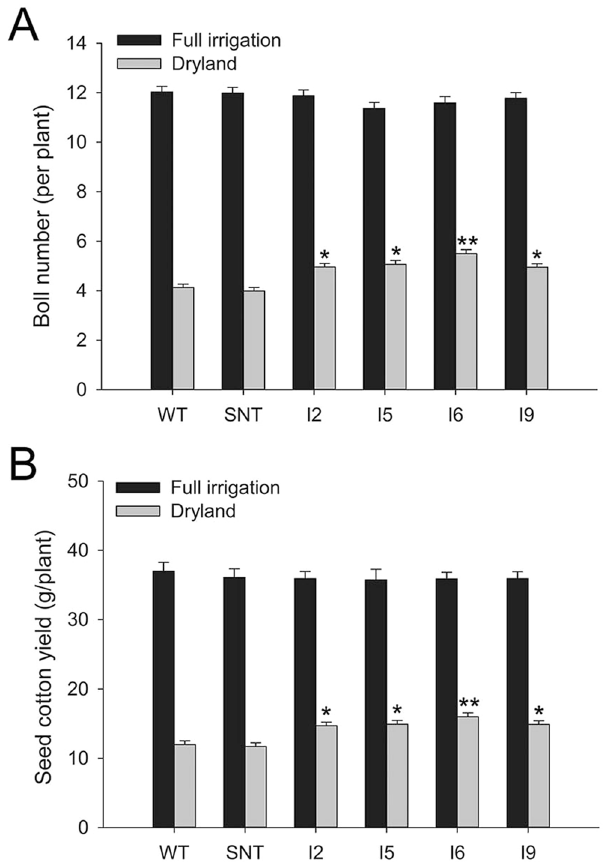
Figure 2. Boll number and seed cotton yields of cotton lines under full irrigation and dryland conditions in 2011. WT, wild-type cotton (Coker 312); SNT, segregated non-transgenic cotton; IPT2 to IPT9, four independent IPT -transgenic cotton lines. Black bar, full irrigation condition; grey bar, dryland condition. * Statistically significant at the < 0.05 level; ** statistically significant at the < 0.01